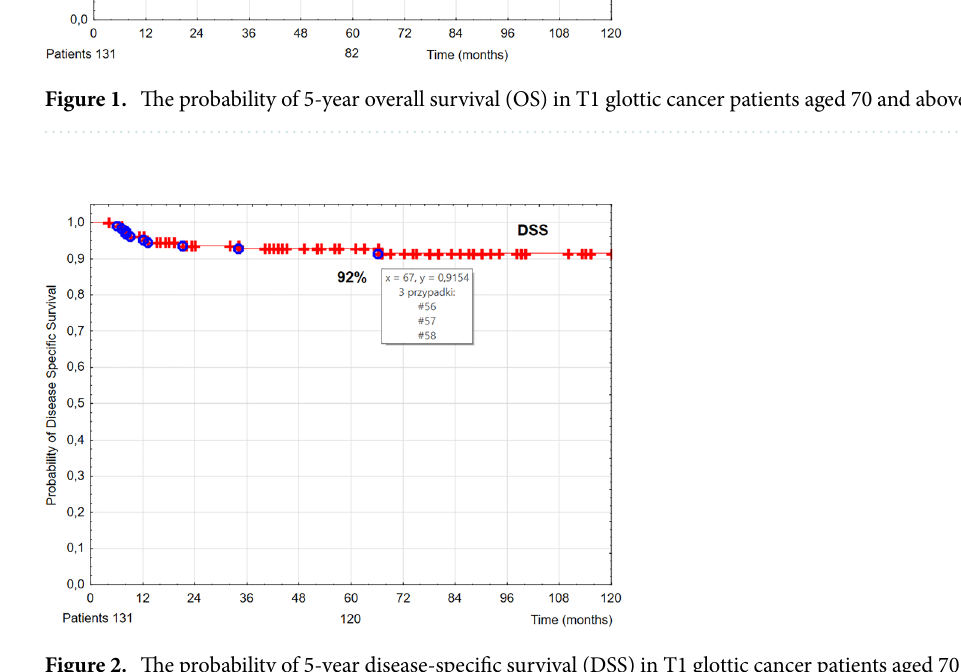
Figure 2. The probability of 5-year disease-specific survival (DSS) in T1 glottic cancer patients aged 70 and